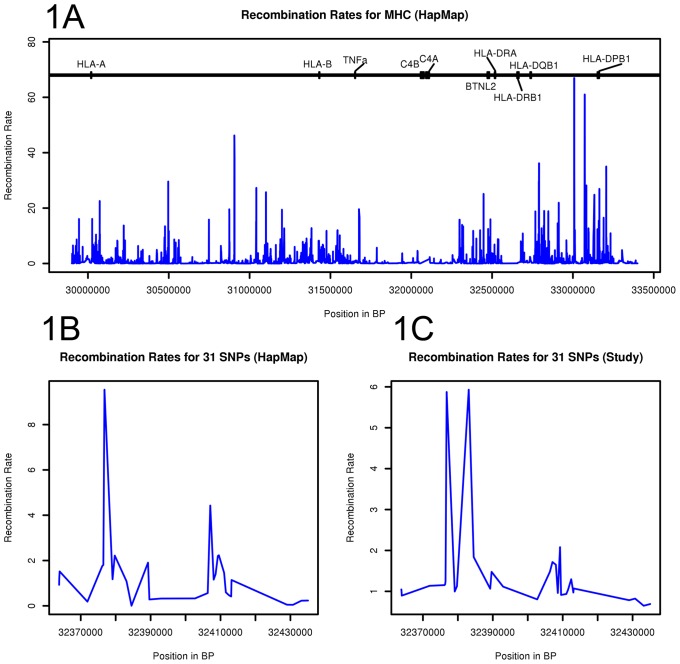
Recombination rates in MHC region.1A: The recombination rates for (HapMap [28]) in MHC region. 1B: Recombination rates in HapMap [28] for the 31 SNPs that are common in the current study and HapMap. 1C: Recombination rates for the 31 SNPs in the study (that are common in the study and HapMap [28])). The highest recombination rate was observed in the BTNL2 promoter region.